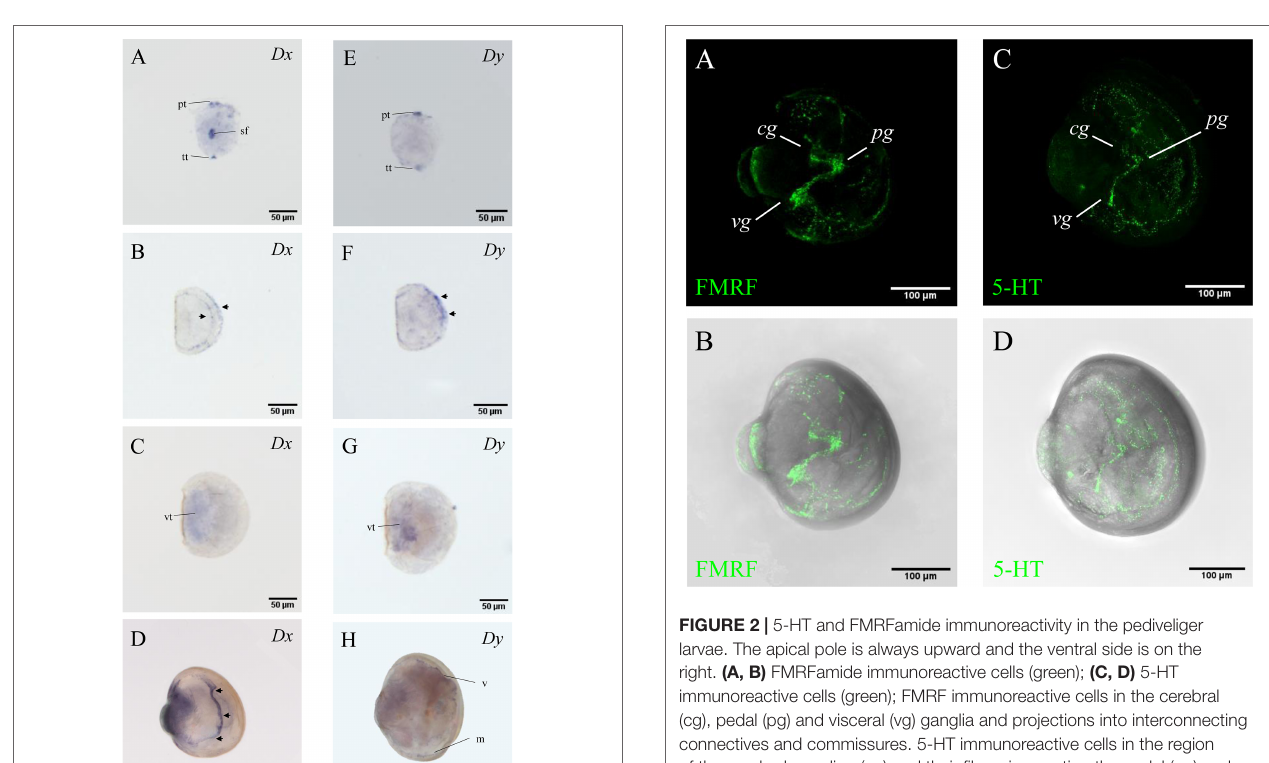
( Figure 3C ). The larval metamorphosis rate of exposure to 0.4